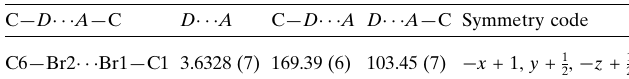
Table 2 Halogen-bond geometry (A˚ , (cid:3) ).